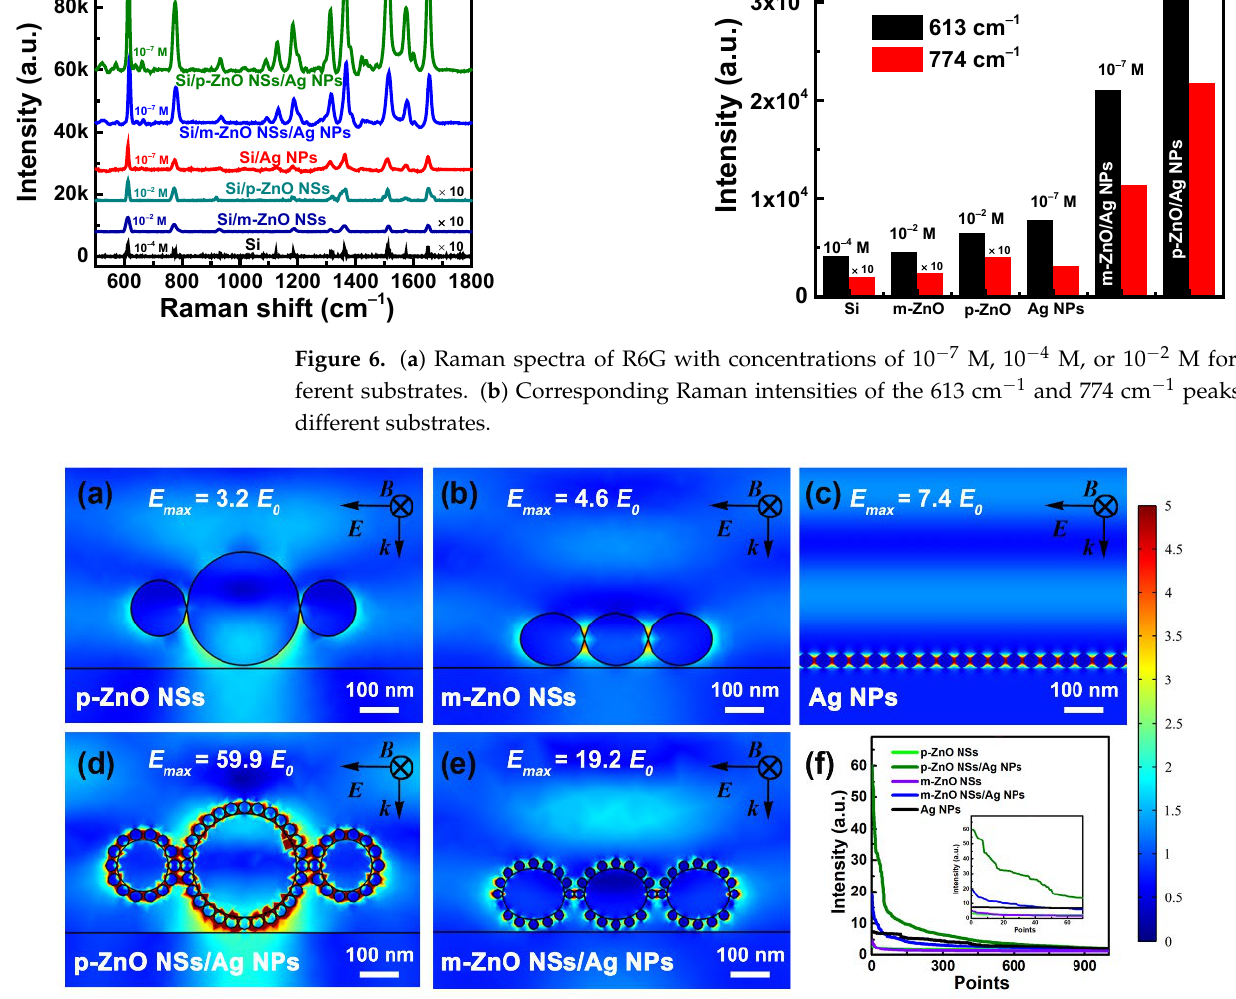
Figure 7. The x-z views of simulated electromagnetic field distributions at 532 nm for the Si/p-ZnO NS ( a ), Si/m-ZnO NS ( b ), Si/Ag NP ( c ), Si/p-ZnO NS/Ag NP ( d ), and Si/m-ZnO NS/Ag NP ( e ) substrates. Corresponding simulated electromagnetic field intensities of best 1000 points for different substrates ( f ).